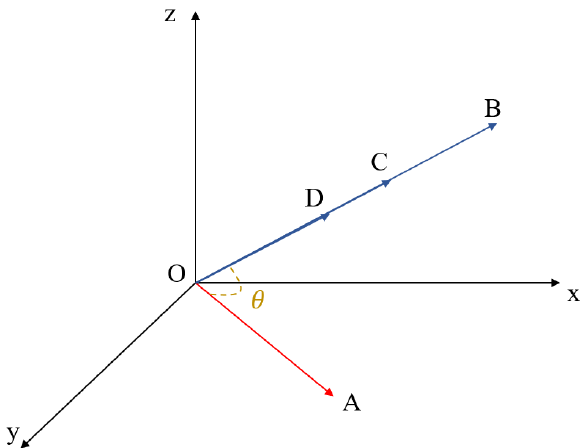
Figure 2. An extreme situation when measuring similarity with cosine similarity.